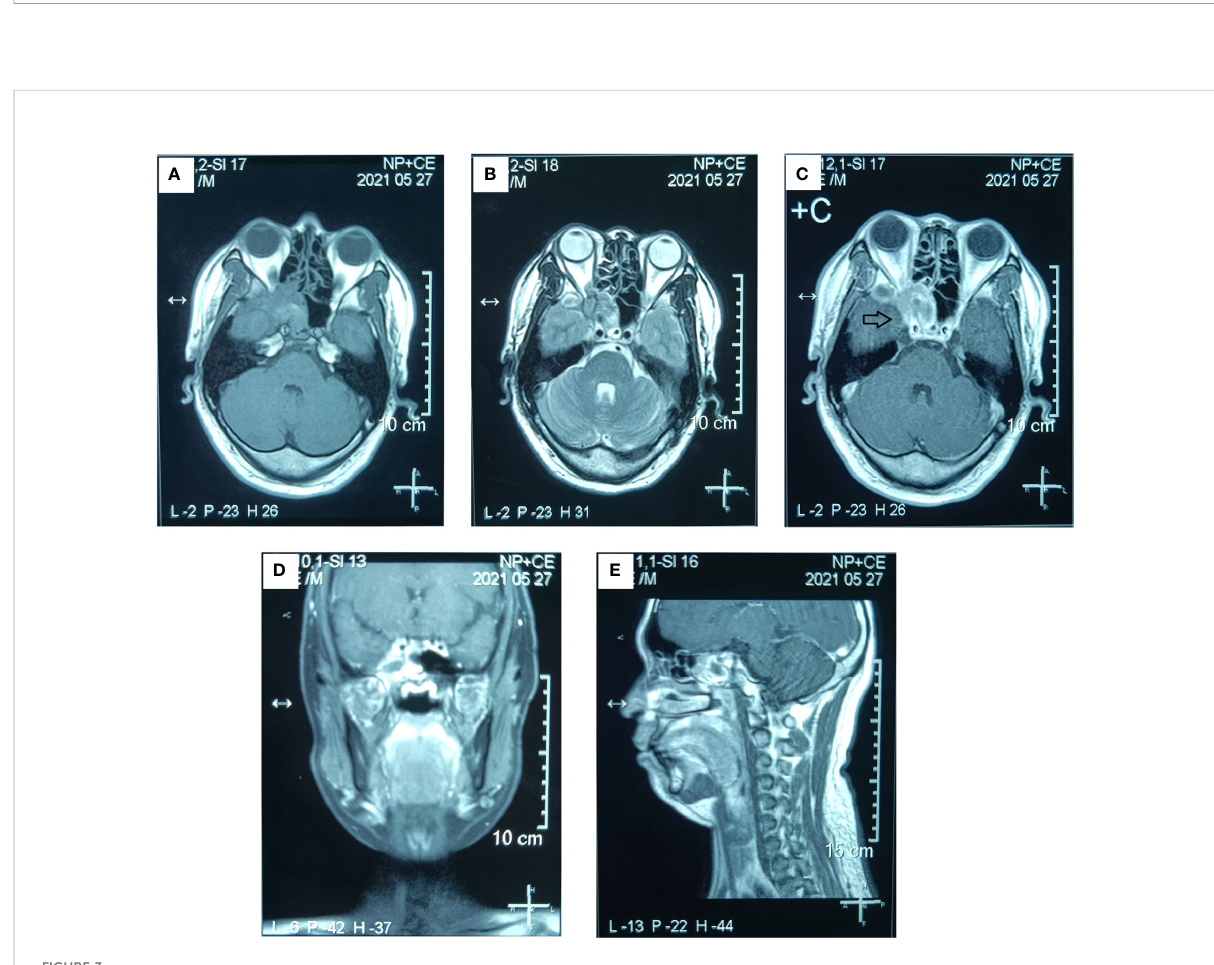
FIGURE 3 Preoperative MR examination of the paranasal sinus. The MR examination detected a solid mass in the right sphenoid sinus that had extended into the right orbital apex and posterior ethmoid sinus. (A) Axial T1-weighted image. (B) Axial T2-weighted image. (C) Axial T1-weighted enhanced image. (D) Sagittal T1-weighted enhanced image. (E) Coronal T1-weighted enhanced image. (The mass is marked with a black